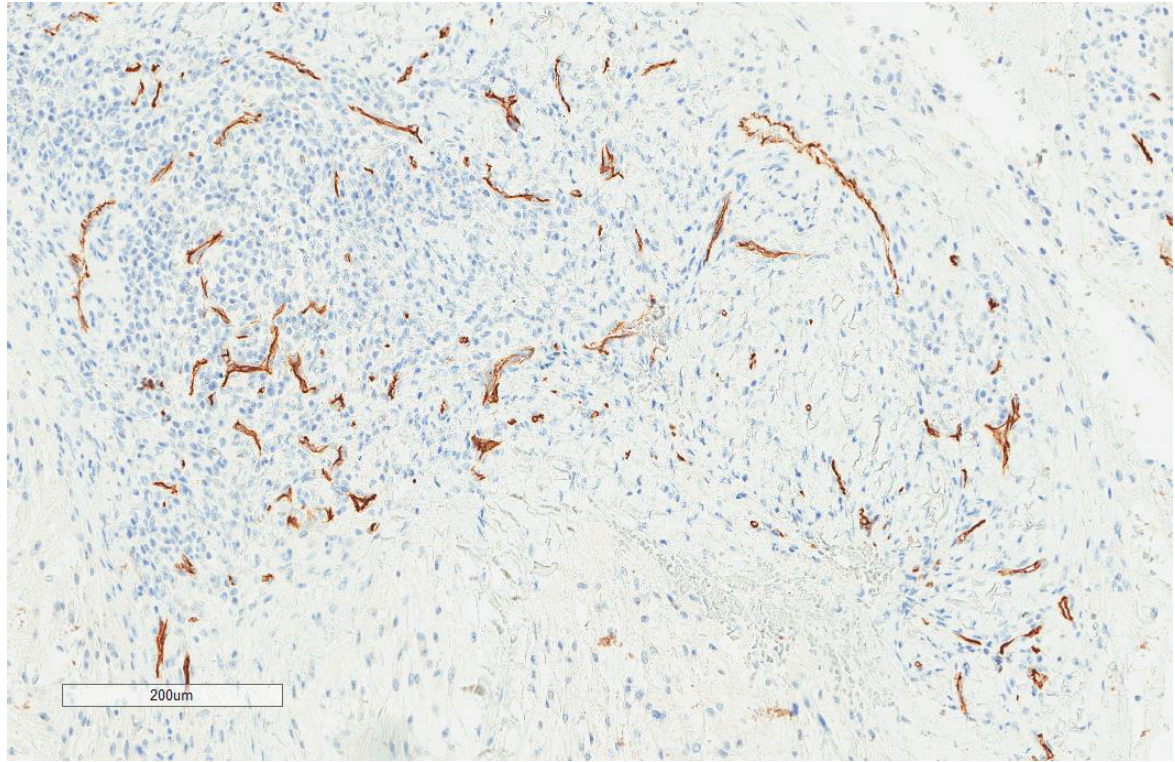
Figure 12. Representative microscopic image of a double stain for PD-L1 (DAB = brown) and CD163 (magenta), showing that most CD163 cells also express PD-L1 (yellow triangle), while the background lymphocytes (red circle) are negative (×400 magnification, same focus as in the previous figure).